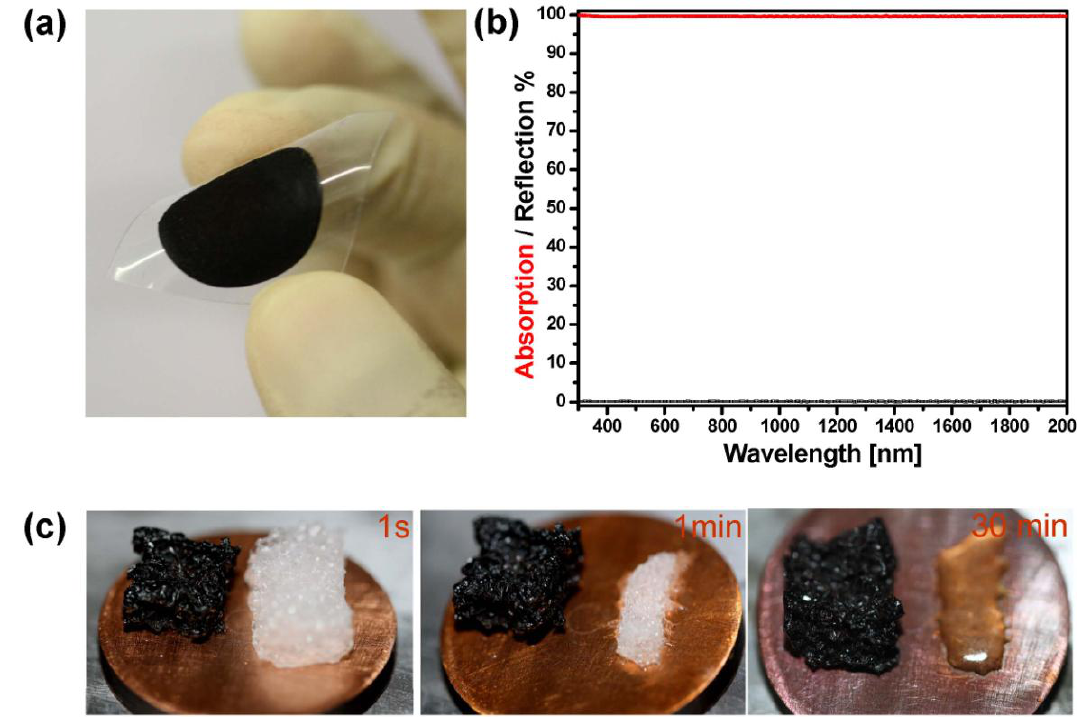
Figure 9. ( a ) A flexible polymeric substrate coated with the black spongy gold; ( b ) Reflection and absorption spectra of black spongy gold in the visible and near-infrared frequency; ( c ) Heating stages of coated (black) and neat foam (white) on a hot plate after (bottom-left) 1 s, (bottom-middle) 1 min and (bottom-right) 30 min at 150 °C. (Reprinted with permission from [104]. Copyright 2013, Nature Publishing